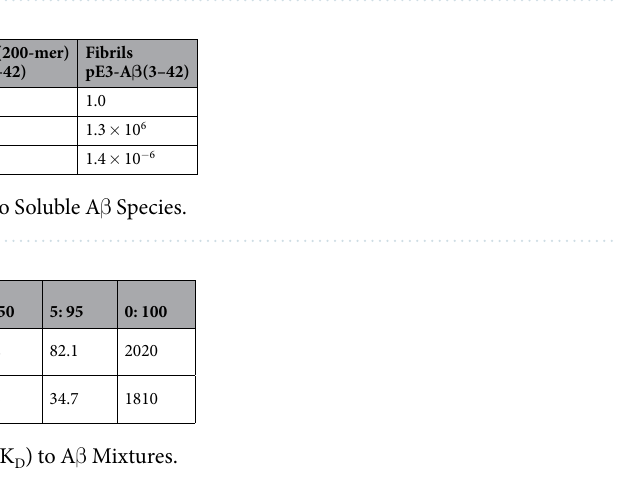
Figure 1. Binding of murine PBD-C06 to A β monomers. Sensograms of human pE3-A β (3–40) monomers binding to murine PBD-C06 were obtained with a Biacore 3000 SPR instrument. Binding was determined immediately after monomer preparation, using a flow rate of 30 µ l/min and injecting 240 µ l of 1 nM (light magenta) to 100 nM (green) of pE3-A β (3–40). The sensograms were recorded for 2500 sec and association and dissociation rates were obtained using the 1:1 Langmuir binding model. Resp.Diff. = Difference in Response Units.